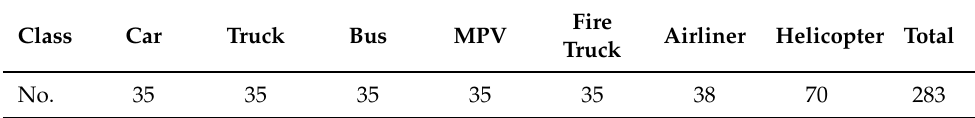
Table 3. The number of images from each class in the VA dataset.